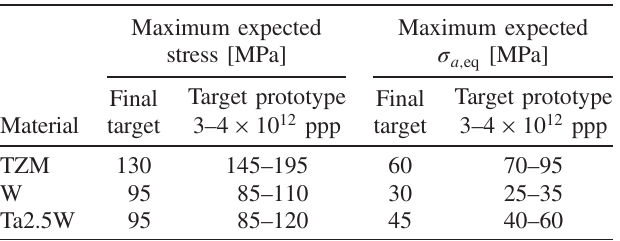
TABLE III. Maximum von Mises equivalent stress and maxi- mum equivalent stress amplitude expected in the target materials for the final target [5] and for the target prototype in a range of two different